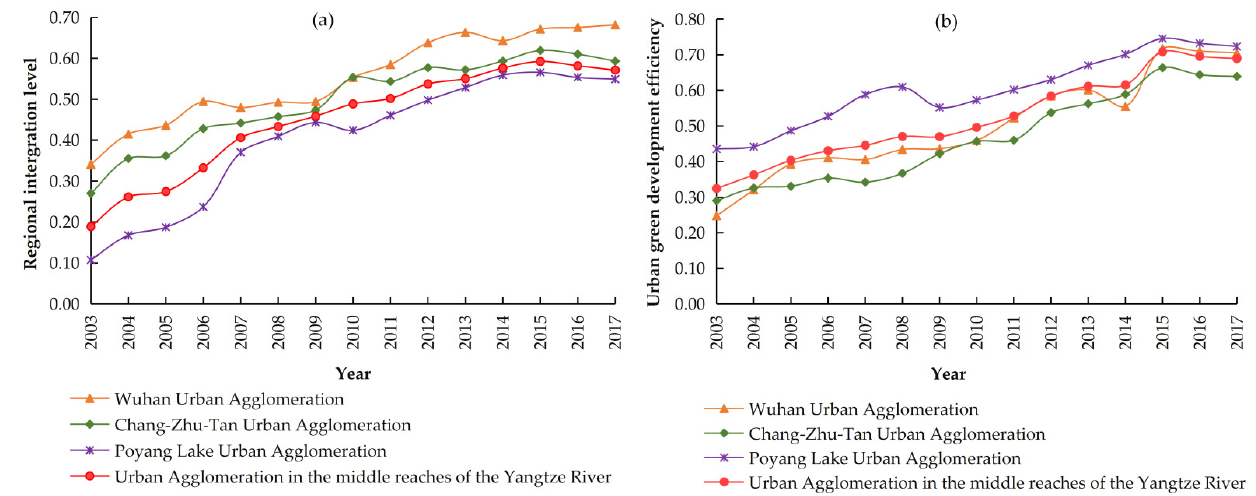
Figure 3. Spatio-temporal evolution of the regional integration level and the UGDE. ( a ) Regional integration leve; ( b ) UGDE.